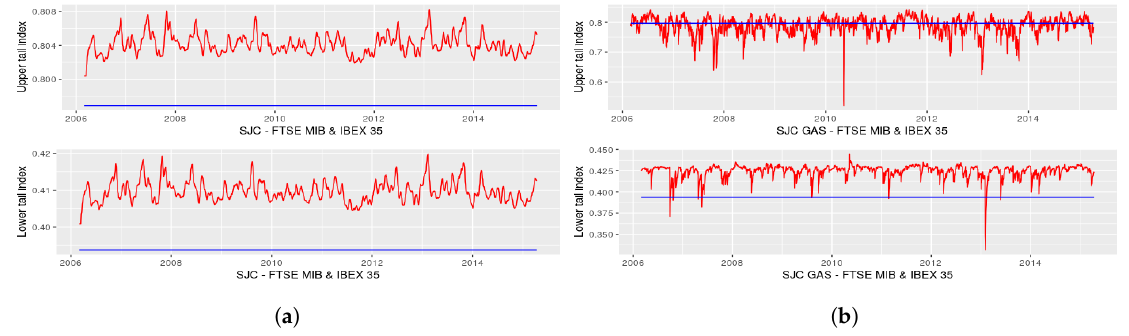
Figure 4. Upper and lower tail indices of FTSE MIB–IBEX 35; ( a ) SJC copula with dynamic Equation (6); ( b ) SJC copula with dynamic Equation